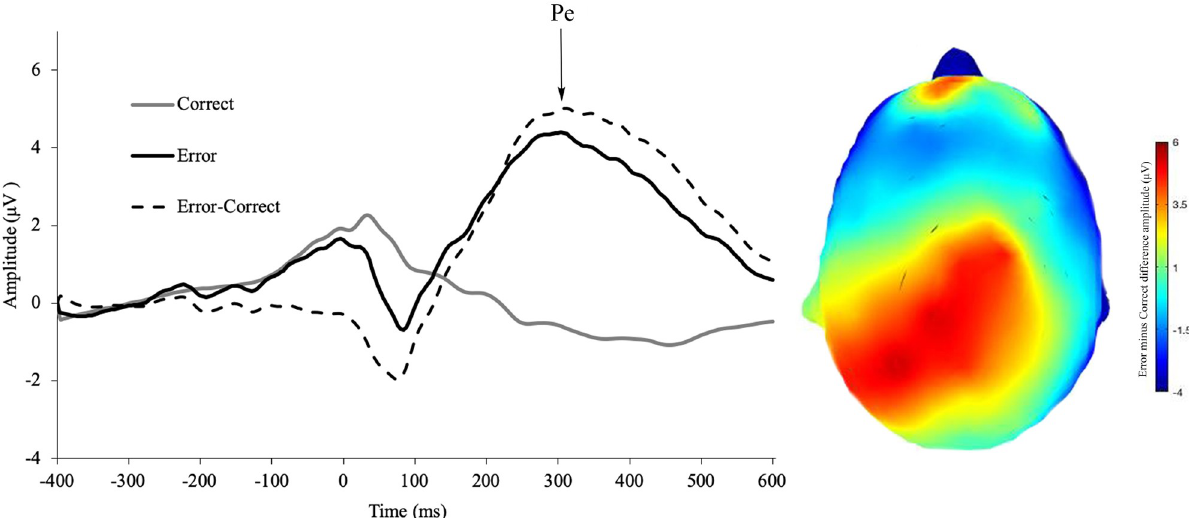
Fig 4. Pe for erroneous responses, correct responses, and the difference wave during the flanker task. Scalp distribution of the difference wave (incorrect minus correct responses).